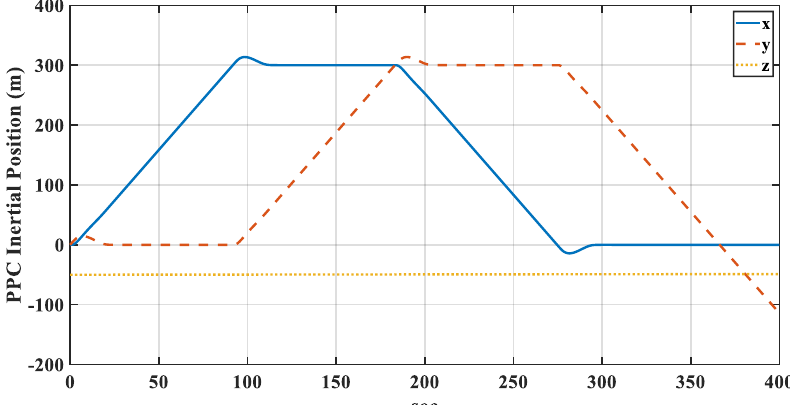
Figure 11. Inertial position using the non-optimized FLC.